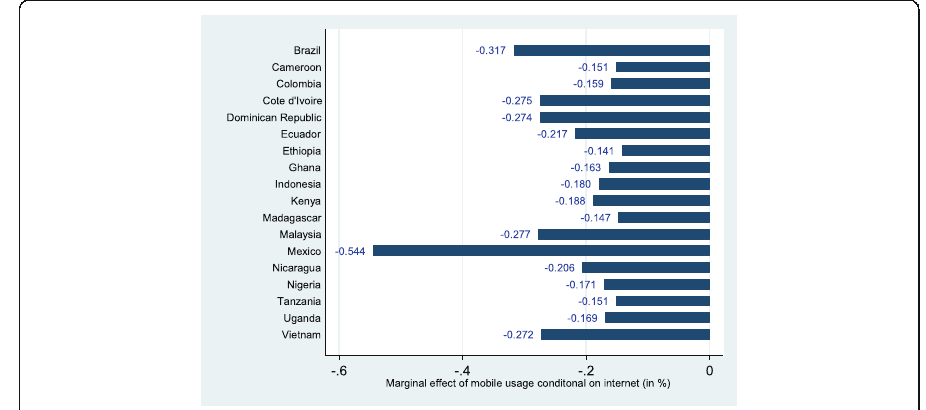
Fig. 3 Total effect of mobile phone usage on the extent of price distortion by